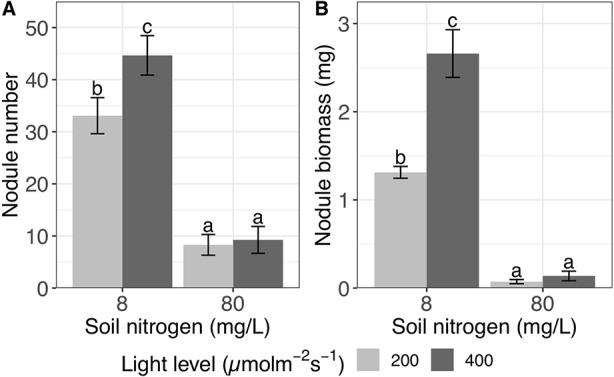
Effects of light and nitrogen on total nodulation. (A) Nodule number and (B) nodule biomass in inoculated Medicago truncatula plants in response to changing soil nitrogen and light availability levels. Error bars represent +/− one standard error (8–11 replicates). Note that nodule biomass was ln-transformed to improve normality in the ANOVA but is represented here without transformation for ease of interpretation. Bars with the same letter within an individual panel do not significantly differ after Tukey post hoc testing (P > 0.05).